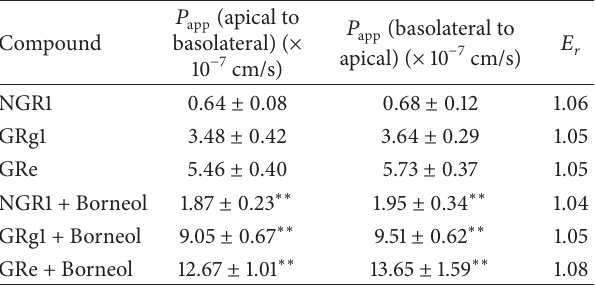
Table 6: Apparent permeability coefficients ( 𝑃 and GRe with or without the addition of 200 𝜇 M Borneol on the Caco-2